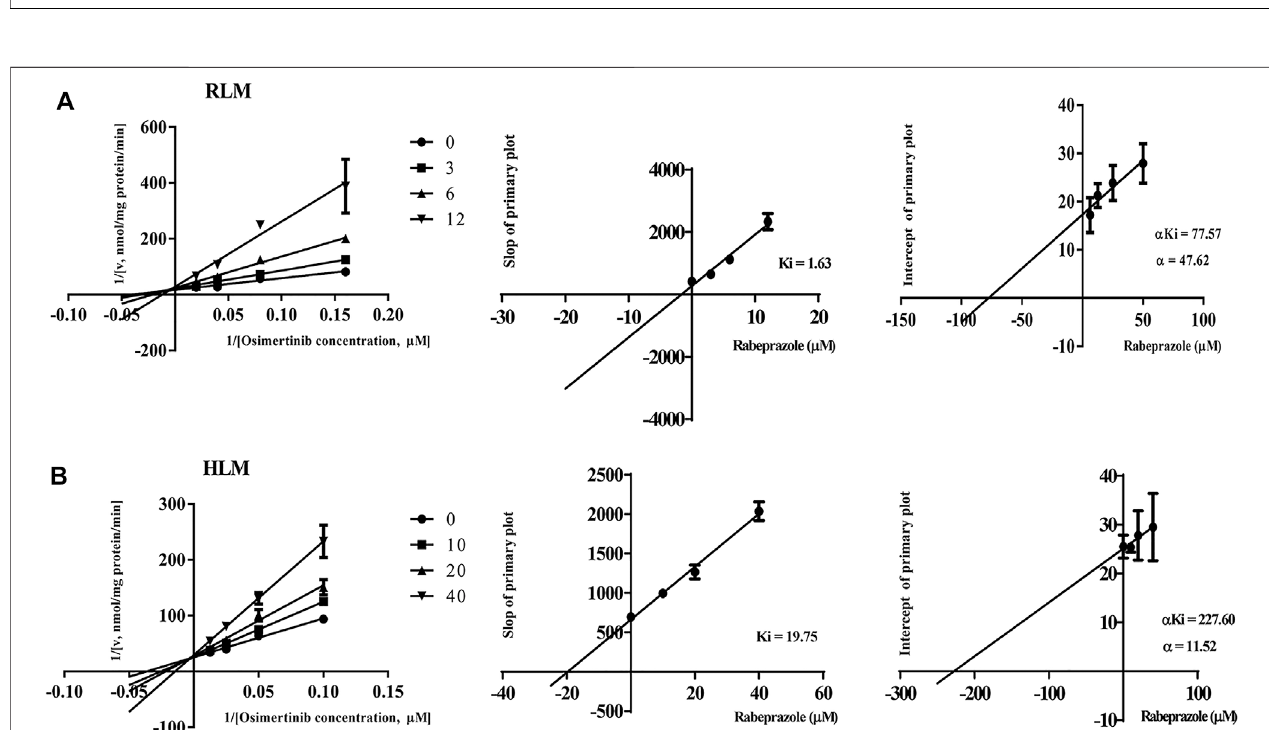
FIGURE 4 | Lineweaver – Burk plot, the secondary plot for K i , and the secondary plot for α K i for the inhibition of osimertinib metabolism by rabeprazole with various concentrations in (A) rat liver microsome (RLM) and (B) human liver microsome (HLM). Data are presented as the means ± SD, n = 3.